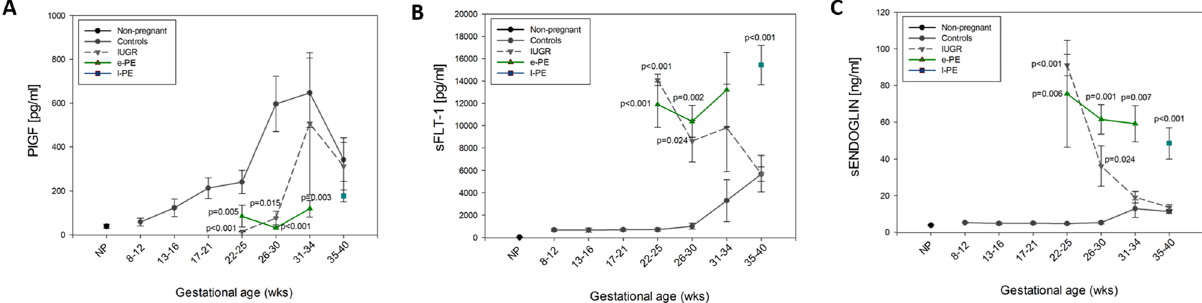
Figure 2. PlGF, sFLT-1 and sENDOGLIN levels in non-pregnant, healthy pregnant women, IUGR-, Early PE- and Late PE- affected pregnant women along gestation. Mean (± SE) levels of Placental Growth Factor (PlGF, ( A ), soluble fms-like tyrosine kinase 1 (sFLT-1, ( B ) and soluble Endoglin (sENDOGLIN, ( C ) in plasma of non-pregnant women (NP), healthy pregnant women (Controls), IUGR-, Early PE- (e-PE) and Late PE- (l-PE) affected pregnant women throughout pregnancy as measured by ELISA. Data were compared using the two-sample t -test between two samples or ANOVA test among more than two groups. Statistically significant difference within gestational interval is reported. SigmaPlot 12.0 and GraphPad Prism 7 were used for statistical